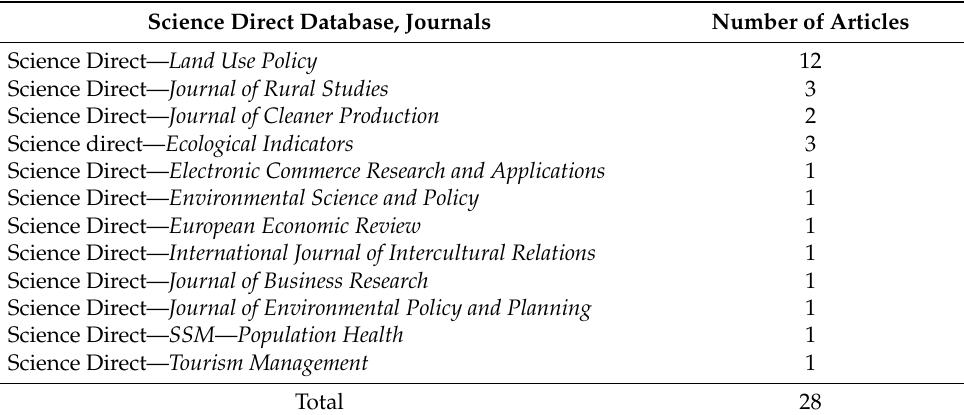
Table 2. The number of articles from the Science Direct